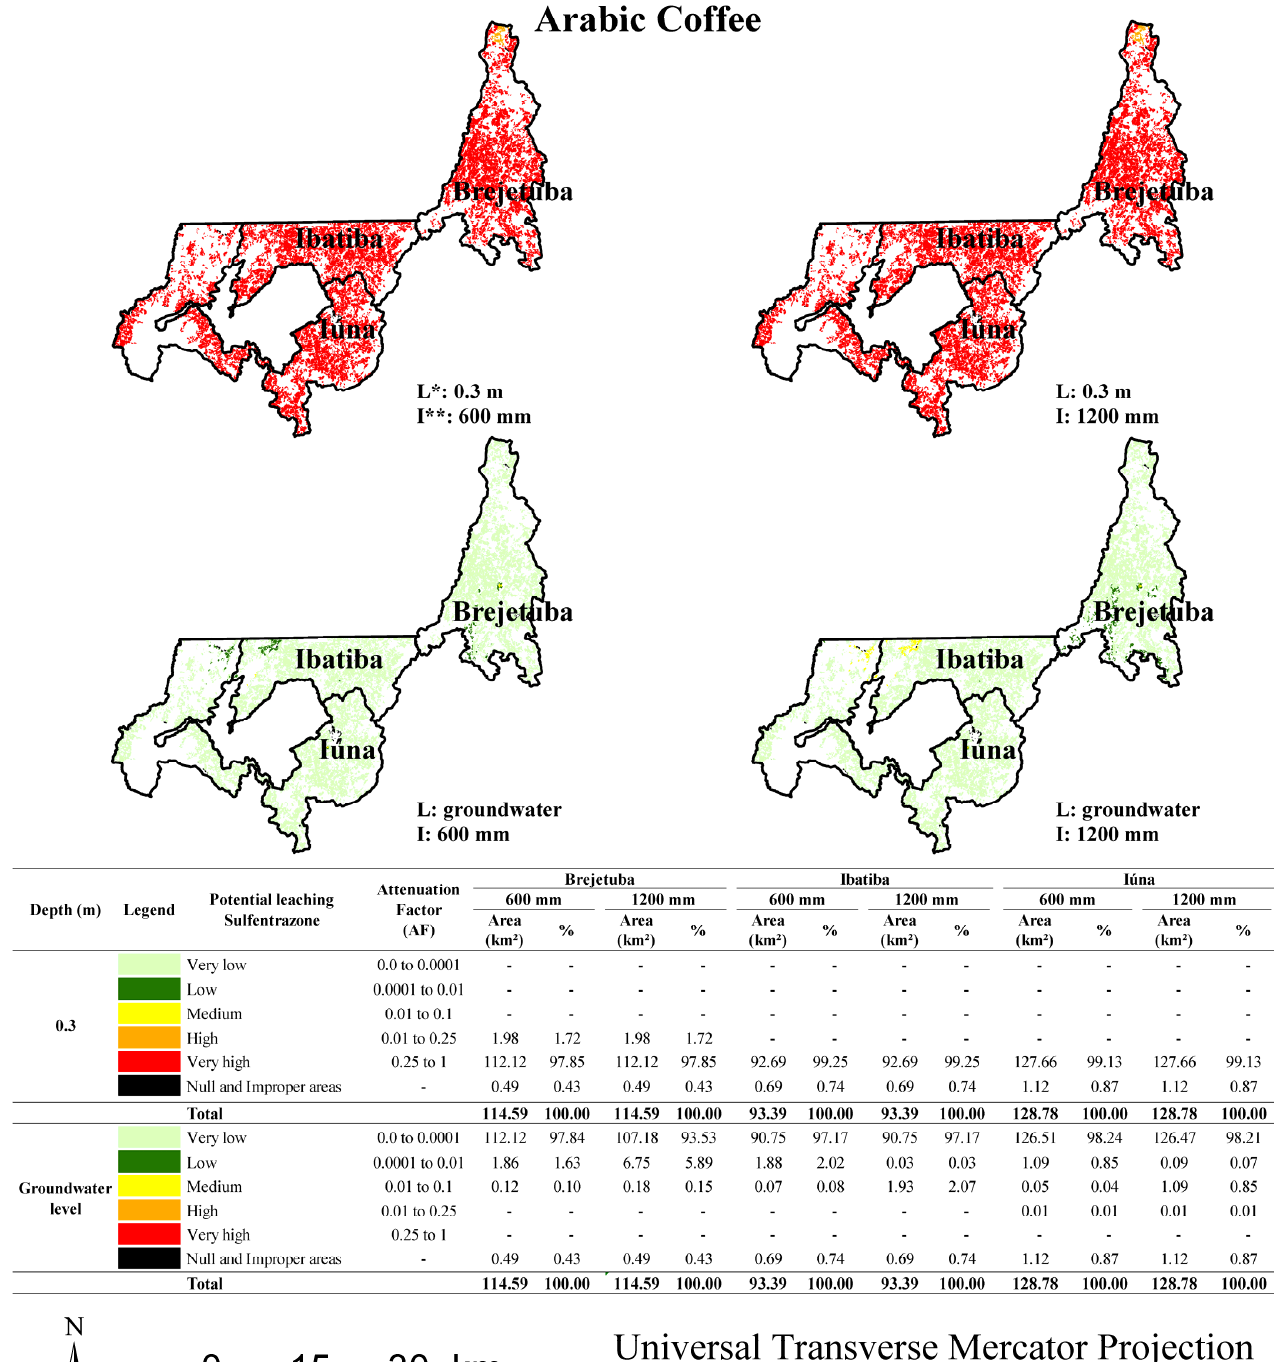
Figure 6. Attenuation Factor (AF) of active ingredient sulfentrazone evaluated for areas cultivated with arabica coffee ( Coffea arabica L.) for the municipalities of Brejetuba, Ibatiba and Iúna, ES, Brazil. * L: Groundwater depth and ** I: Irrigation.